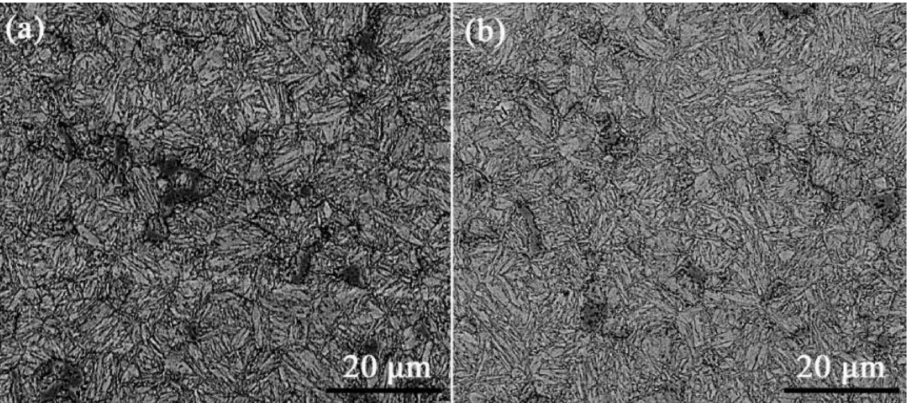
Figure 4. The SEM photographs of the specimen that experienced fatigue tests of 450 MPa for 10,000 cycles under magnetic field of 1.2–1.3 T ( a ) and no magnetic field ( b